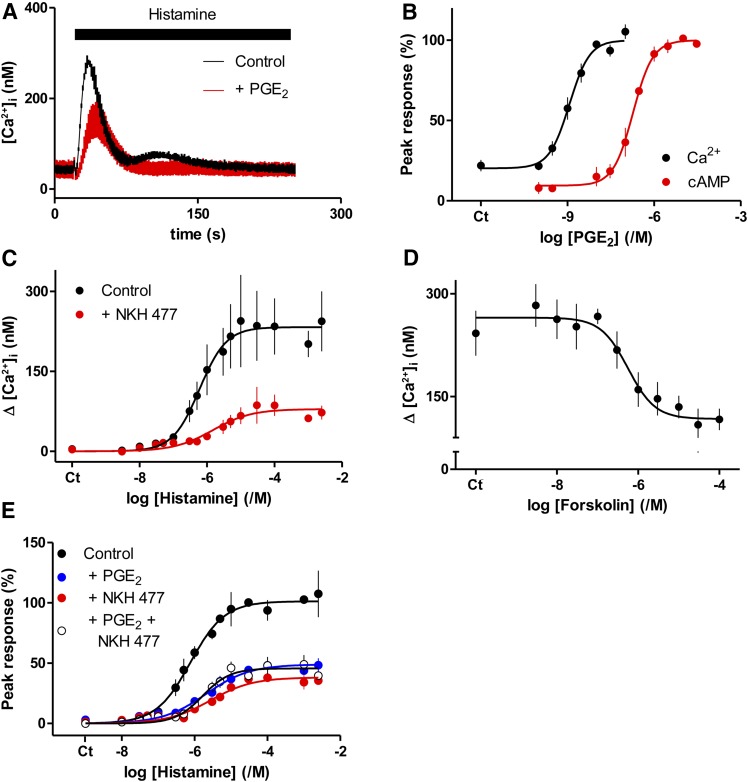
Inhibition of histamine-evoked Ca2+ signals by PGE2 is mediated by cAMP. (A) Ca2+ signals evoked by histamine (3 μM, black bar) alone or with PGE2 (10 μM, added 5 minutes before and then during stimulation with histamine). Results show means ± range from two wells on a single plate; they are typical of results from at least four independent experiments. (B) Effects of PGE2 on cAMP accumulation (measured after 5 minutes) and inhibition of the peak Ca2+ signals evoked by histamine (3 μM). Results, as percentages of maximal inhibition (Ca2+) or stimulation (cAMP), are means ± S.E.M. from six and four experiments, respectively. This panel includes some data for cAMP measurements that were published previously (Pantazaka et al., 2013). (C) Effect of NKH 477 (100 μM) on the peak Ca2+ signal evoked by histamine. (D) Concentration-dependent effects of forskolin on the peak Ca2+ signals evoked by histamine (1 mM). (E) Effect of PGE2 (10 μM), NKH 477 (100 μM), or both on the peak Ca2+ signals evoked by histamine (as percentages of the maximal response). NKH 477, forskolin, or PGE2 were added 5 minutes before and then during stimulation with histamine. Results show means ± S.E.M. from four (C and D) or three (E) independent plates with one to three wells analyzed from each. Ct denotes control.